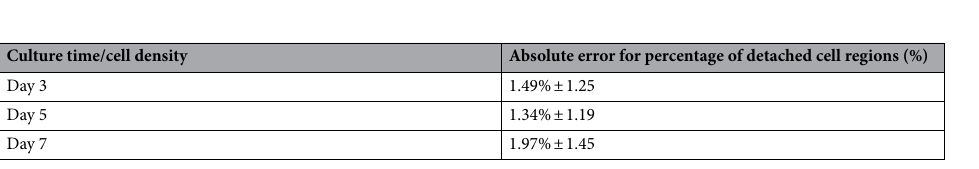
Table 1. Quantitative validation of the developed algorithm for the extraction of the percentage of detached cell regions. The absolute errors are grouped per culture time (i.e. day 3, 5 and 7) and represented as mean ± std. Each validation dataset is composed of 16 images (n =